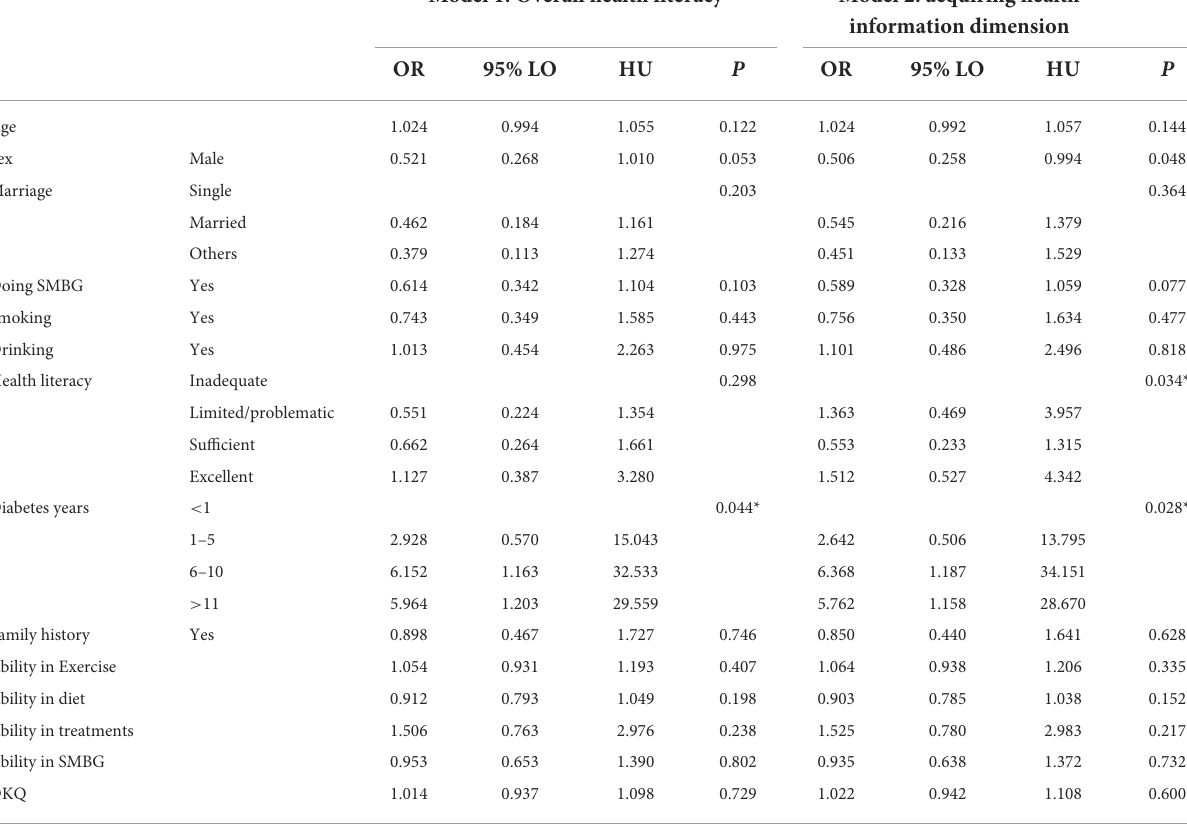
TABLE 6 The relationship between PVD events with health literacy adjusted with other variables from logistics regression. Model 1: Overall health literacy Model 2: acquiring health information